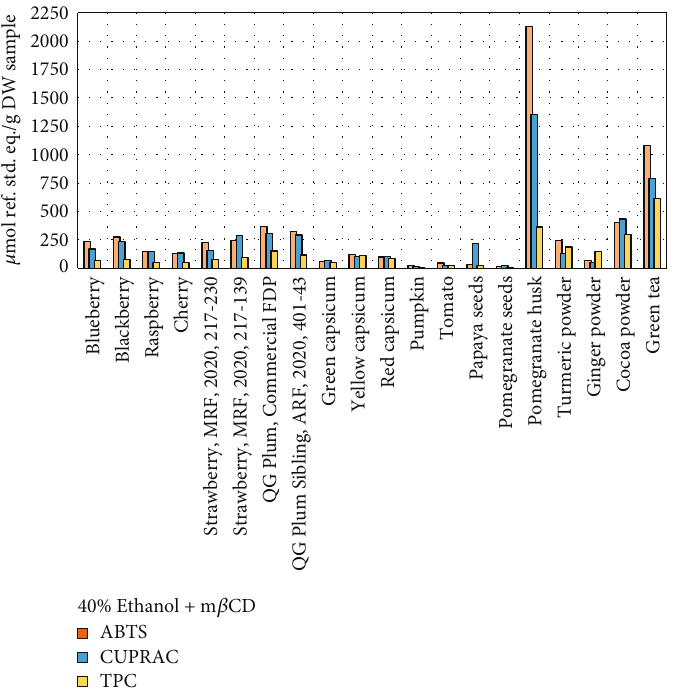
Figure 8: Comparison of ABTS, CUPRAC, and TPC assays in 40% ethanol modi fi ed with m β